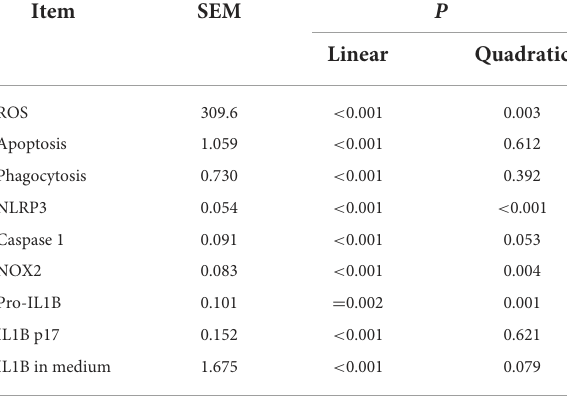
TABLE 2 Linear and quadratic contrasts in monocytes incubated with 3.0 m M BHB over